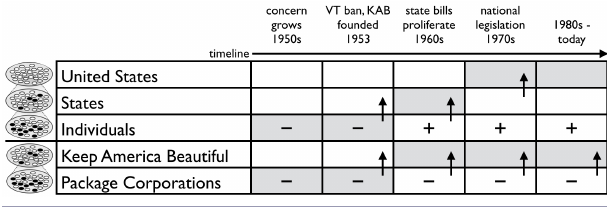
Fig. 6 . Corporations appear to have formed a cooperative supergroup to avoid the costs of solving the litter problem. In the 1950s litter was a growing problem. Litter regulations began to spread, putting costs on litter-producing corporations. In response, corporations formed a cooperative public advocacy group with the goal of casting the responsibility for litter cleanup on individuals. State regulations halted the spread of these litter regulations, and today litter is broadly considered an individual responsibility. Littering and litter production (–), litter cleanup and reduced production (+), cooperation and collective action ( ↑ up arrow). Shaded cells represent dominant level of selection in both corporate and governmental